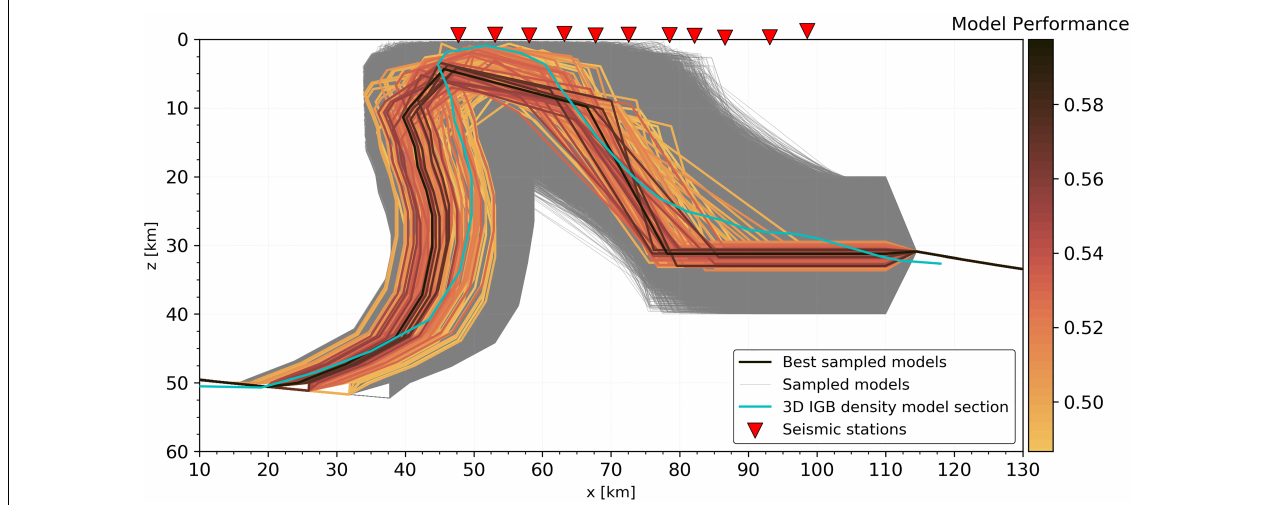
FIGURE 7 | Model geometries resulting from the joint inversion. The 150 best performing models are shown in colored lines according to the model performance. All other sampled and kept models are shown in gray (in total 41’365 models). The cyan dashed line is the cross-section through the 3D IGB gravity model from previous study (Scarponi et al.,